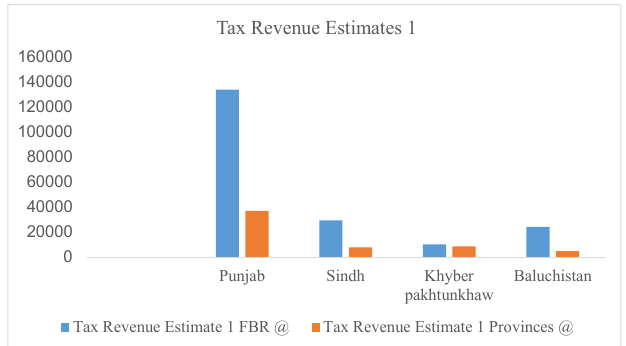
Fig. 3: Tax revenue estimate 1; based on the authors estimates reported in Appendices 3-